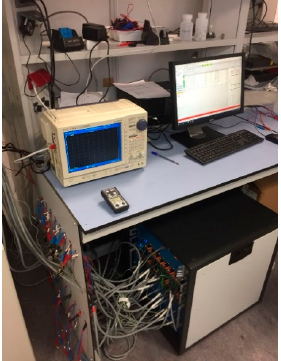
Figure 1 . Image of the testing equipment . Figure 1. Image of the testing